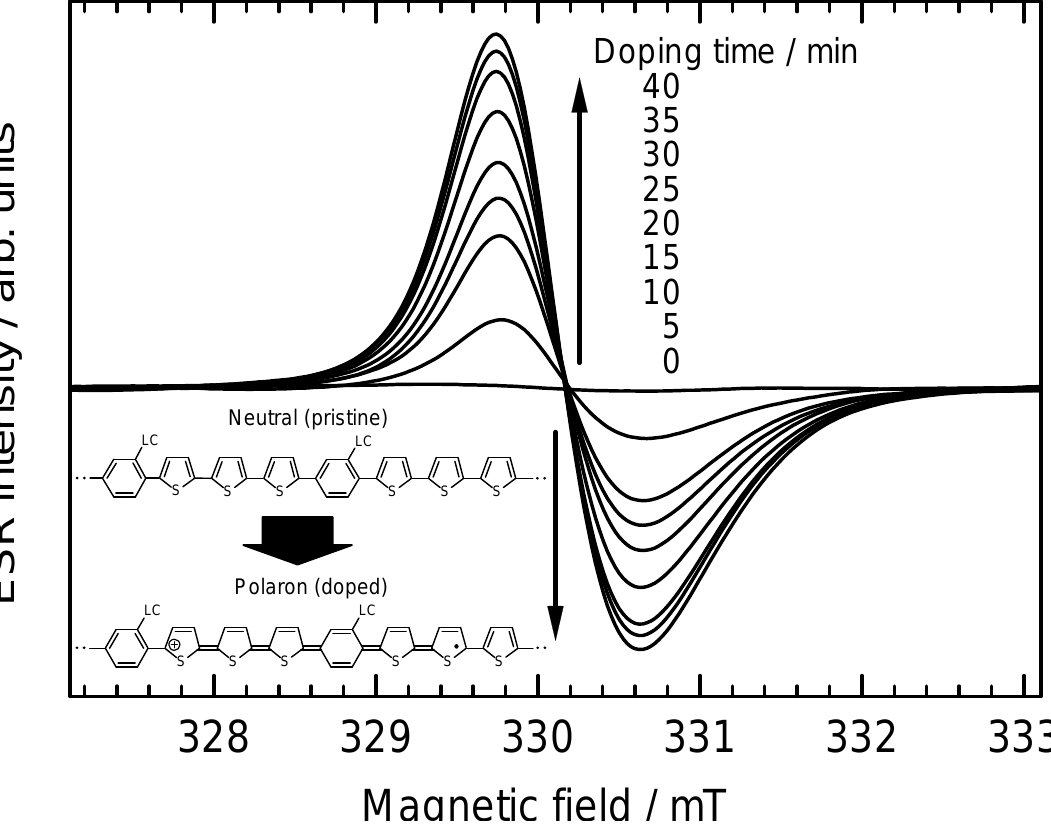
Figure 11. In-situ ESR spectra of polyPLC3Th during vapor phase doping of iodine.